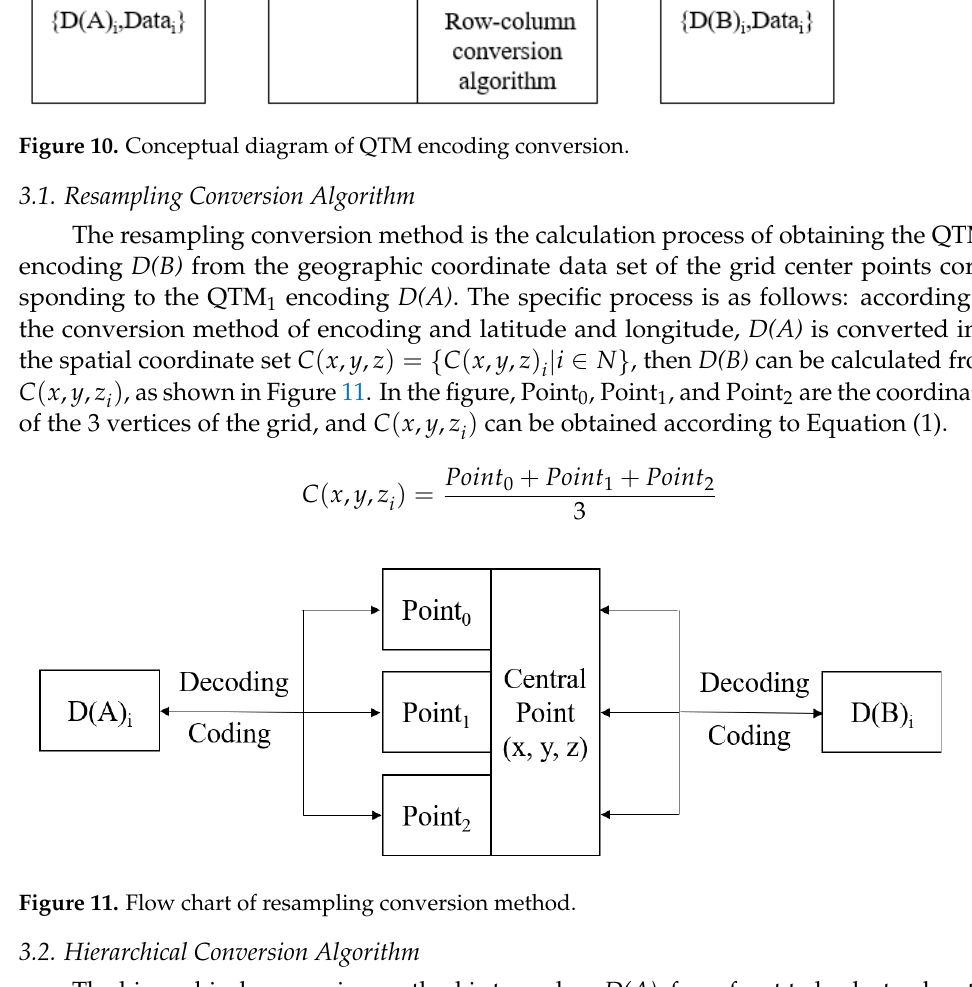
Figure 11. Flow chart of resampling conversion method.